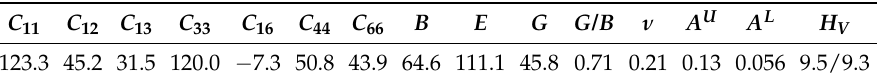
Table 3. Summary of the aggregate characteristics calculated for Y 2 H 3 O(OH) in terms of the elasticity tensor ( C ij ), the bulk ( B ), shear ( G ), and Young’s ( E ) moduli (in GPa): The relation G / B is Pugh’s ratio, ν denotes Poisson’s ratio, and the indexes A U and A L describe the elastic anisotropy. Estimates of the Vickers hardness are given via H V (in GPa). The longitudinal elastic anisotropy ratio C 33 / C 11 (cid:39) 0.97.